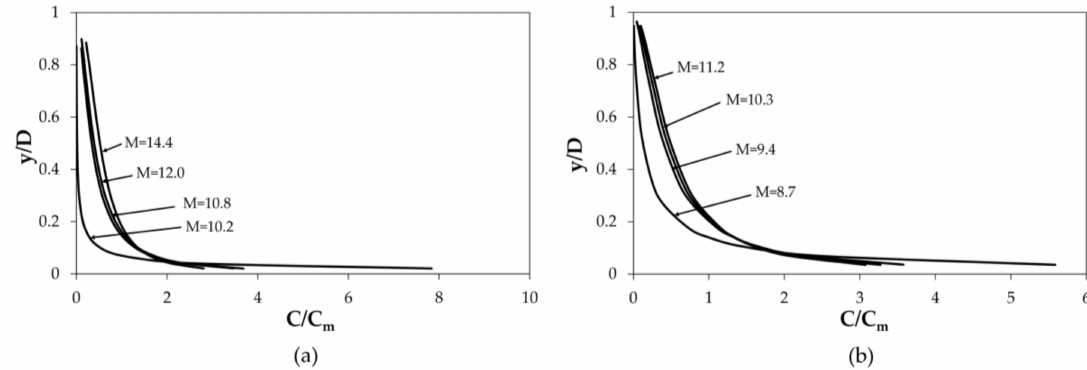
Figure 4. Relationship between parameter M and concentration distribution degree of uniformity at constant values of λ : ( a ) Valiani’s data at λ = 5.9 and ( b ) Coleman’s data at λ = 5.6.